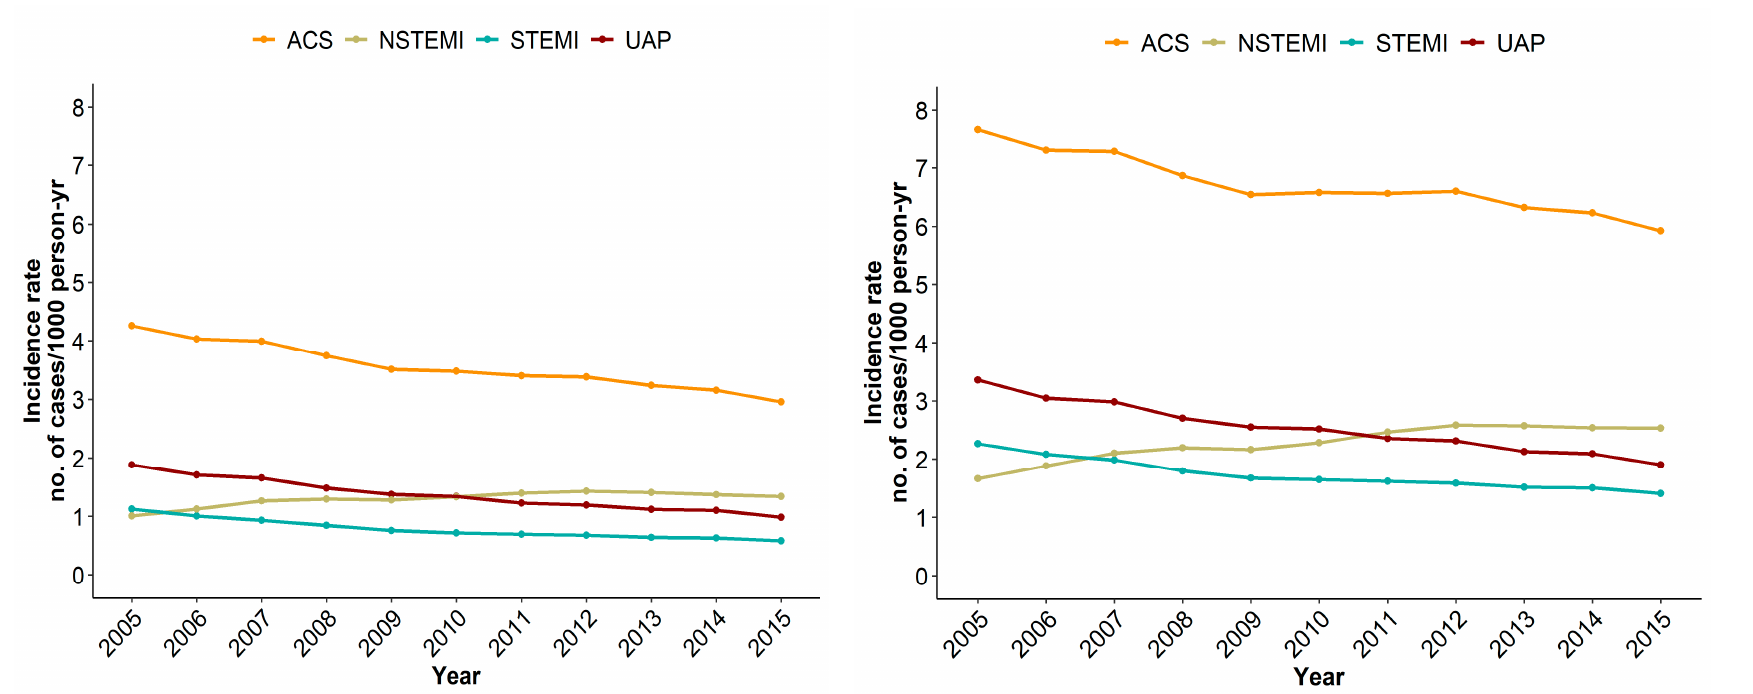
Figure 1. Age-adjusted incidence rates of ACS, NSTEMI, STEMI, and UAP in males and females in cases per 1000 person years from 2005 to 2015.